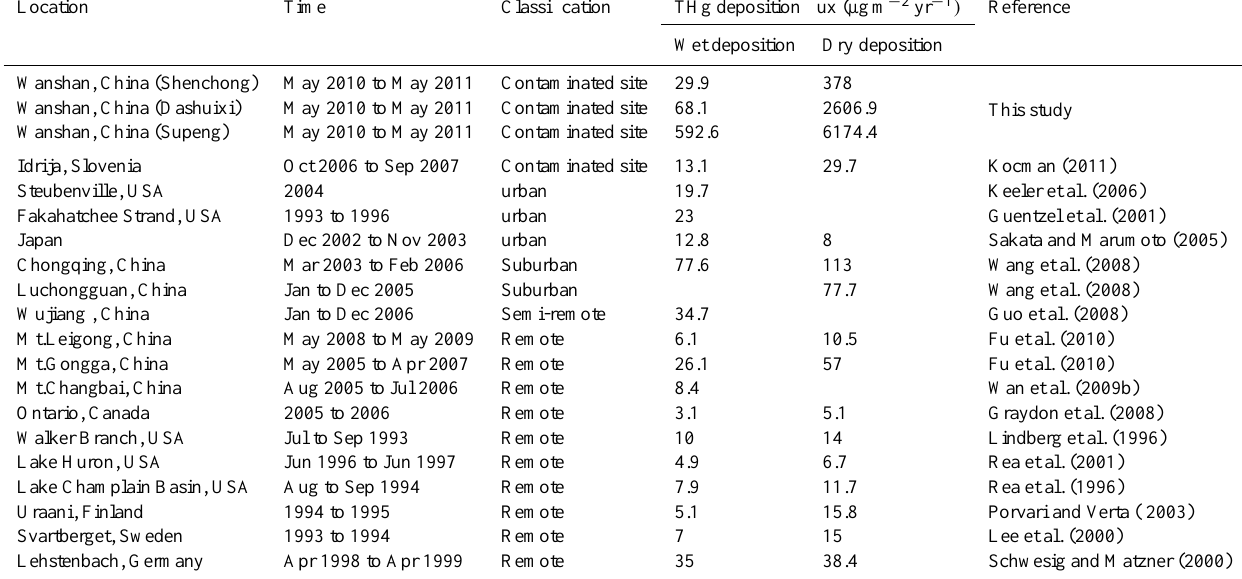
Table 3. Comparison of THg deposition fluxes measured in this study with those measured in some related studies globally.